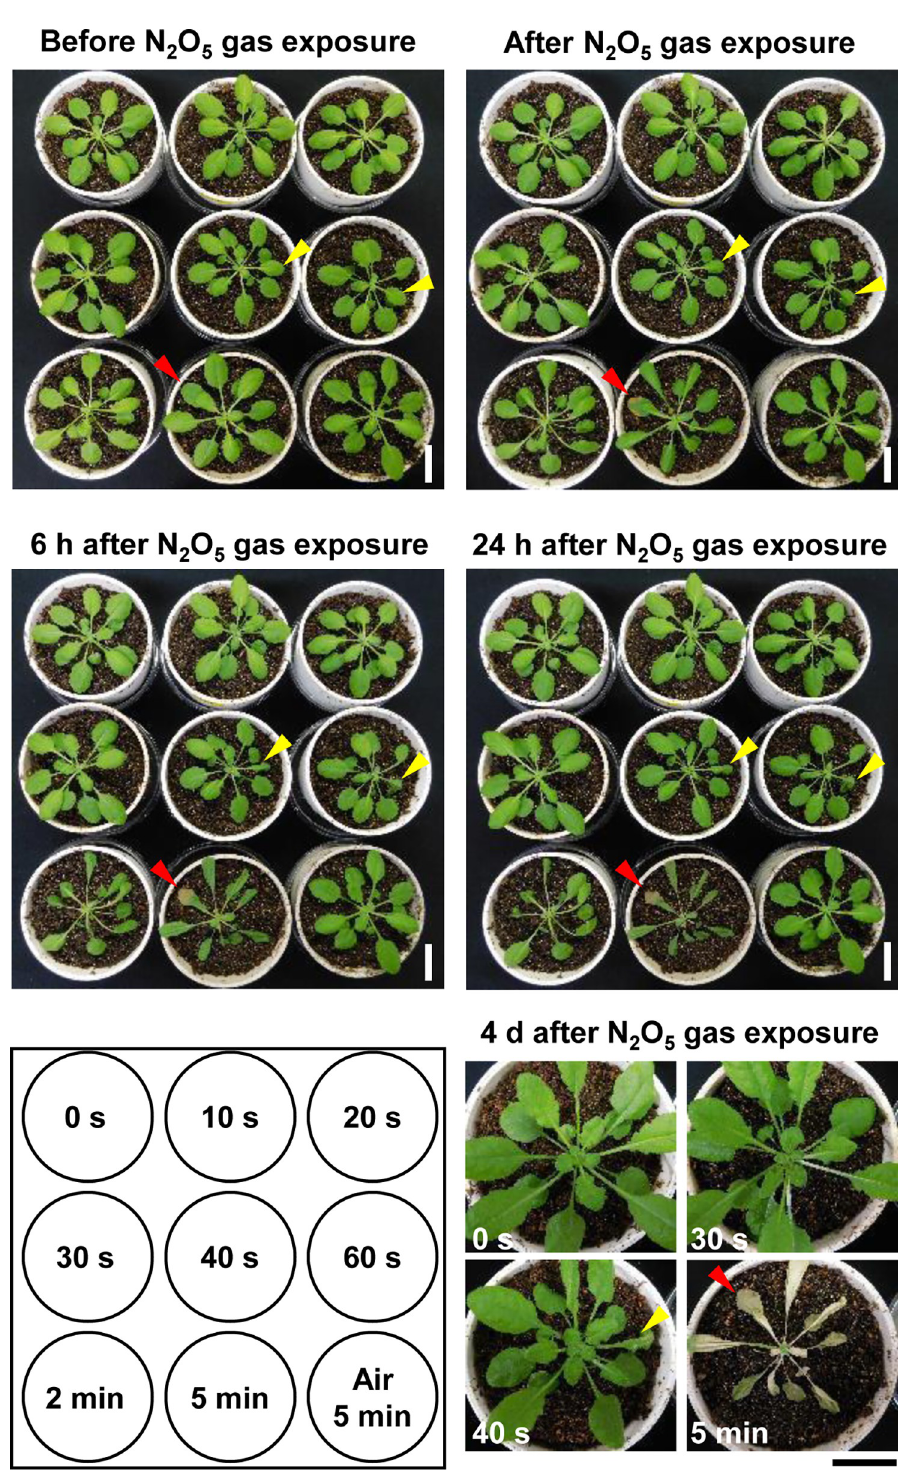
Fig 1. Observation of plant damage after exposure of Arabidopsis plants to N 2 O 5 gas. The N 2 O 5 gas exposure time for each plant is shown in the lower left corner. Observations were made before, immediately after, 6 h after, 24 h after, and 4 days after N 2 O 5 gas exposure. Magnified images at 4 days after some of the N 2 O 5 gas exposure times (0 s, 30 s, 40 s, and 5 min) are shown in the lower right corner. Red arrowheads indicate a leaf that turned brown immediately after the N 2 O 5 gas exposure. Yellow arrowheads indicated the location of leaves that were damaged by the N 2 O 5 gas. Scale bar is 2 cm. https://doi.org/10.1371/journal.pone.0269863.g001 PLOS ONE | https://doi.org/10.1371/journal.pone.0269863 June 24,